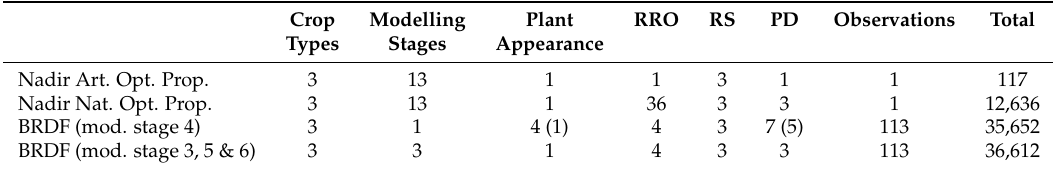
Table 3. Number of canopy modelling scenarios, in total about 85,000 drat computations. Crop Modelling Plant RRO RS PD Observations Total Types Stages Appearance Nadir Art. Opt.